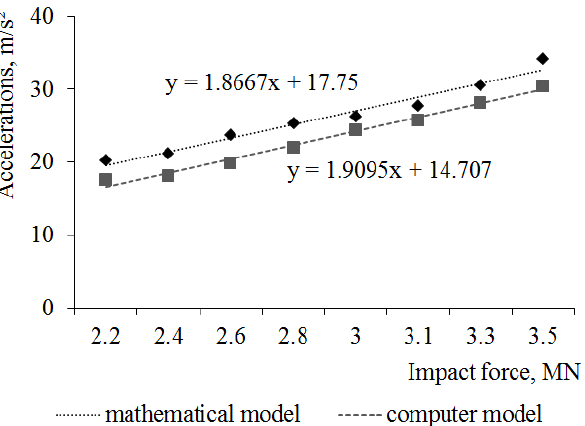
Figure 12. Dependencies between the accelerations to the removable module placed on a flat wagon and the impact force to the coupler. and the impact force to the